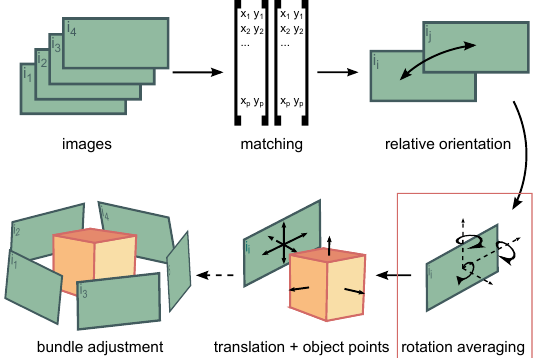
Figure 1: Workflow of our global image orientation approach.